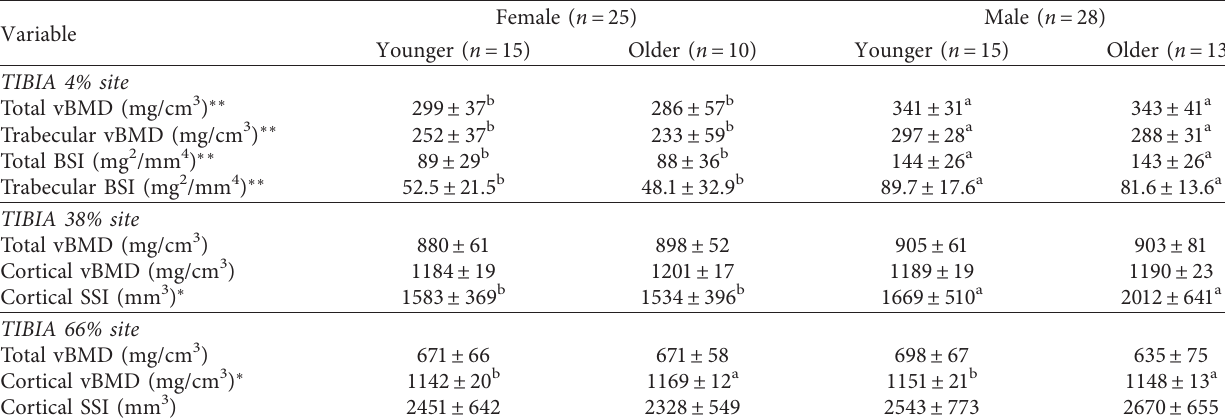
Table 4: pQCT bone quantity and quality (mean ± SD).